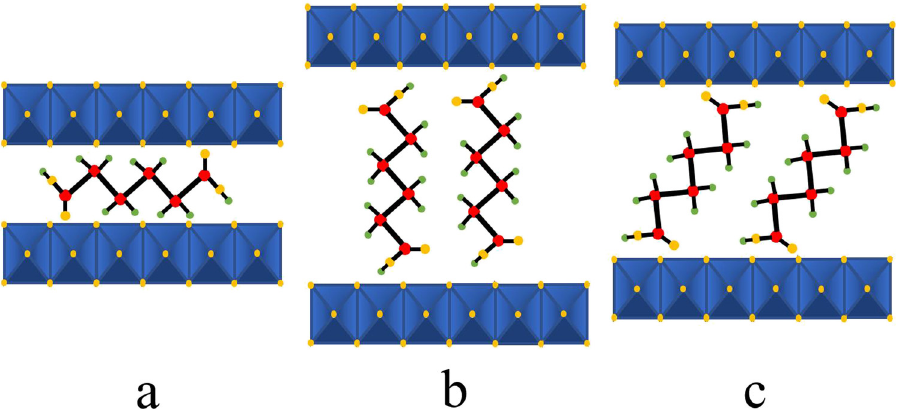
Figure 5: Arrangement of molecules: ( a ) horizontal; ( b ) vertical; and ( c )